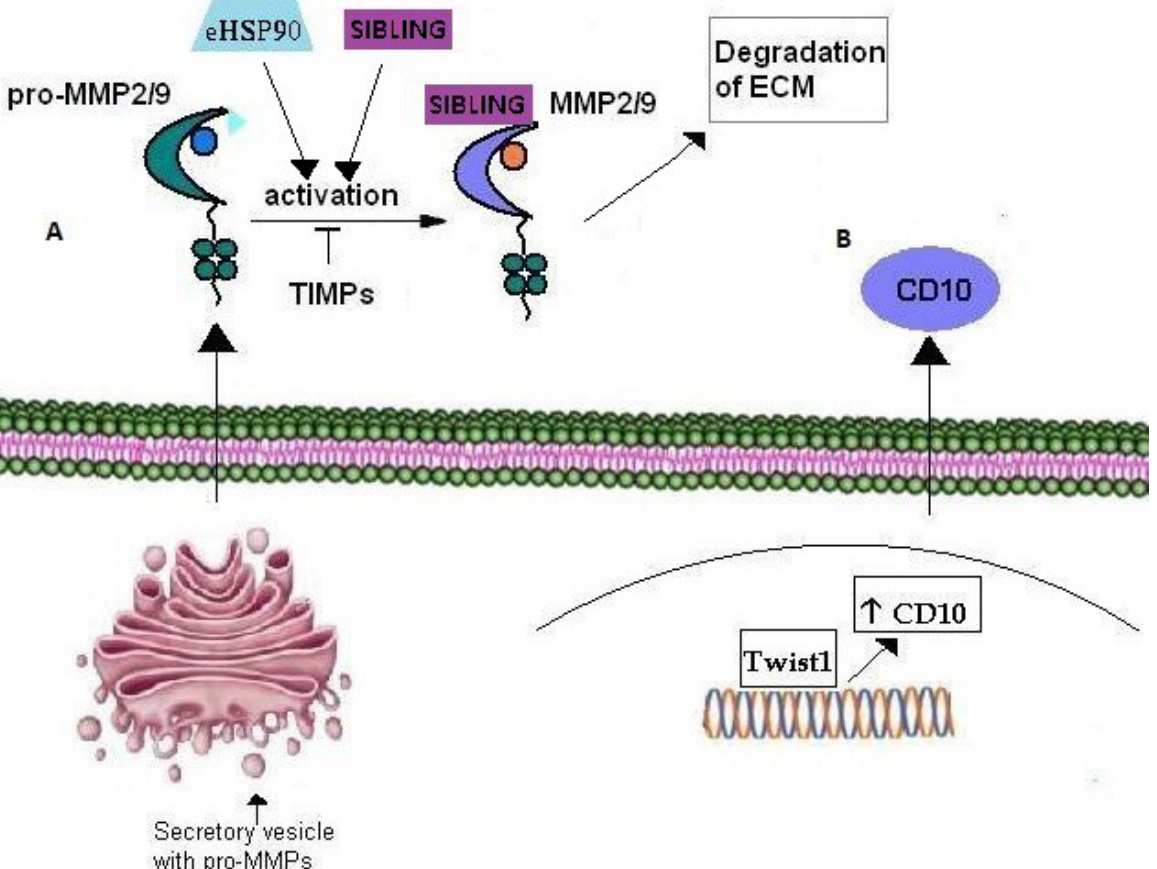
Figure 3. Role of Matrix Metalloproteinases in cancer cell invasion. ( A ) Pro-MMP2/9 are transported through secretory vesicles of the Golgi network to the plasma membrane. Their activation occurs extracellularly through their interaction with eHSP90 and SIBLING that consequently bind the active MMP2/9. TIMPs have an inhibitory effect on MMP2/9 activation. ( B ) CD10 metalloproteinase over-expression is correlated with cancer cell invasion in several tumors. Moreover, CD10 expression is up-regulated by transcription factor Twist1 which is considered a master inductor of EMT and thus, cancer cell